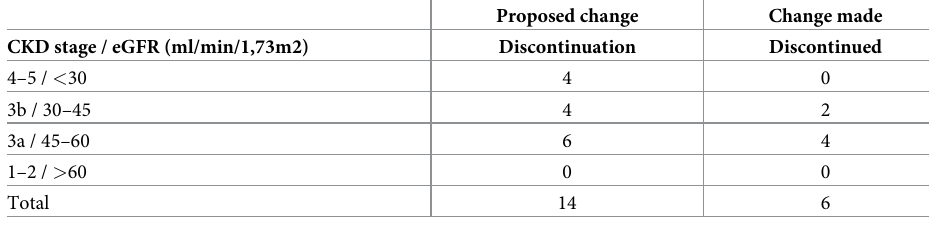
Table 10. Number of patients proposed for and withdrawn from any medicine.